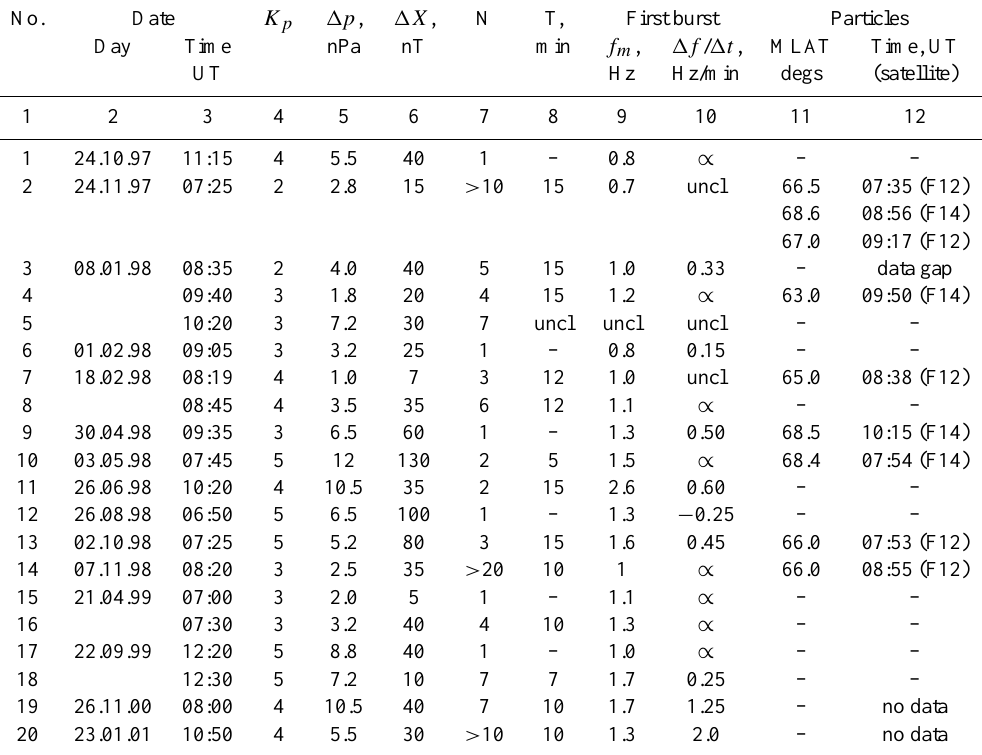
Table 1. Characteristics of sudden impulses and accompanying ULF activity in Pc1 frequency